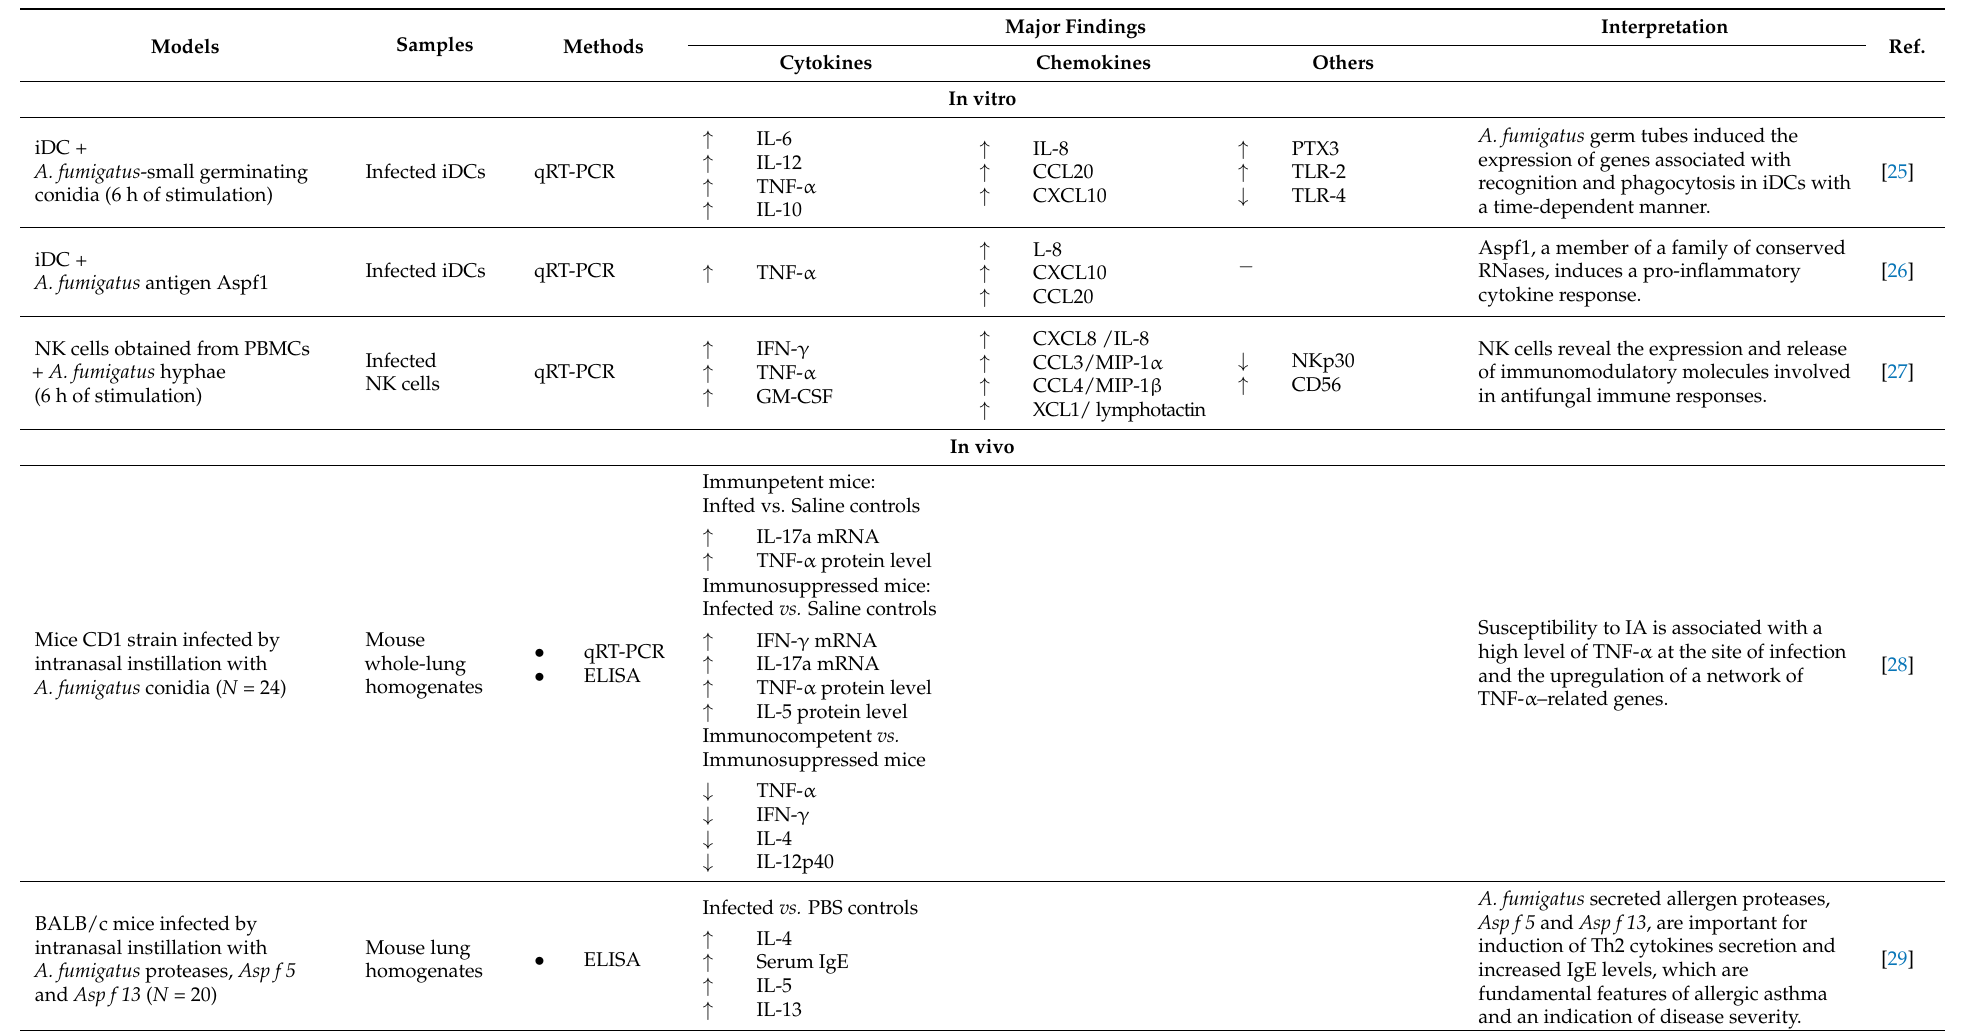
Table 1. Cytokine and chemokine responses in invasive aspergillosis after hematopoietic stem cell